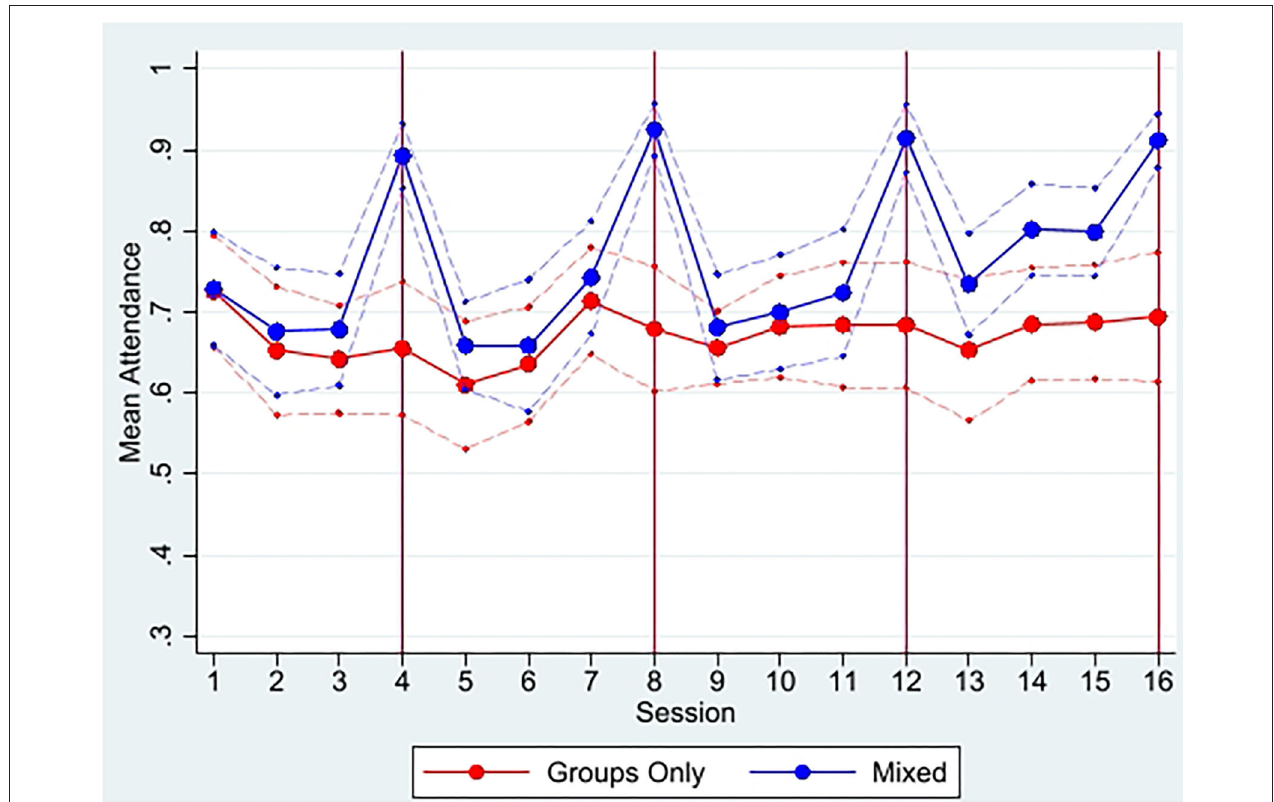
FIGURE 4 | Mean maternal attendance by study arm and session. From attendance monitoring data. Dashed faded lines represent 95% confidence intervals; red vertical lines represent review sessions when sessions were home visits for mixed-delivery arm and group sessions for group-only arm. The only sessions with statistically significant differences in attendance at 95% level or higher are the four review sessions (4, 8, 12, and 16).